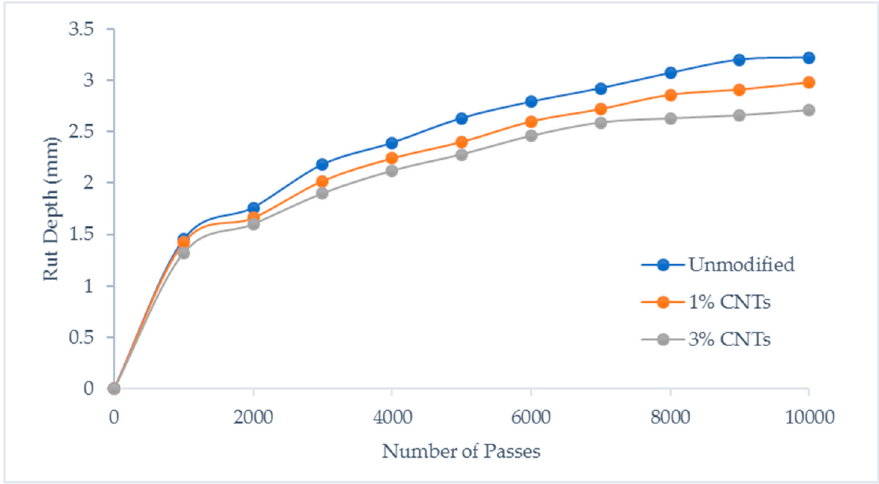
Figure 18. Rut depth for unmodified and CNT-modified bitumen mix at 40 °C.